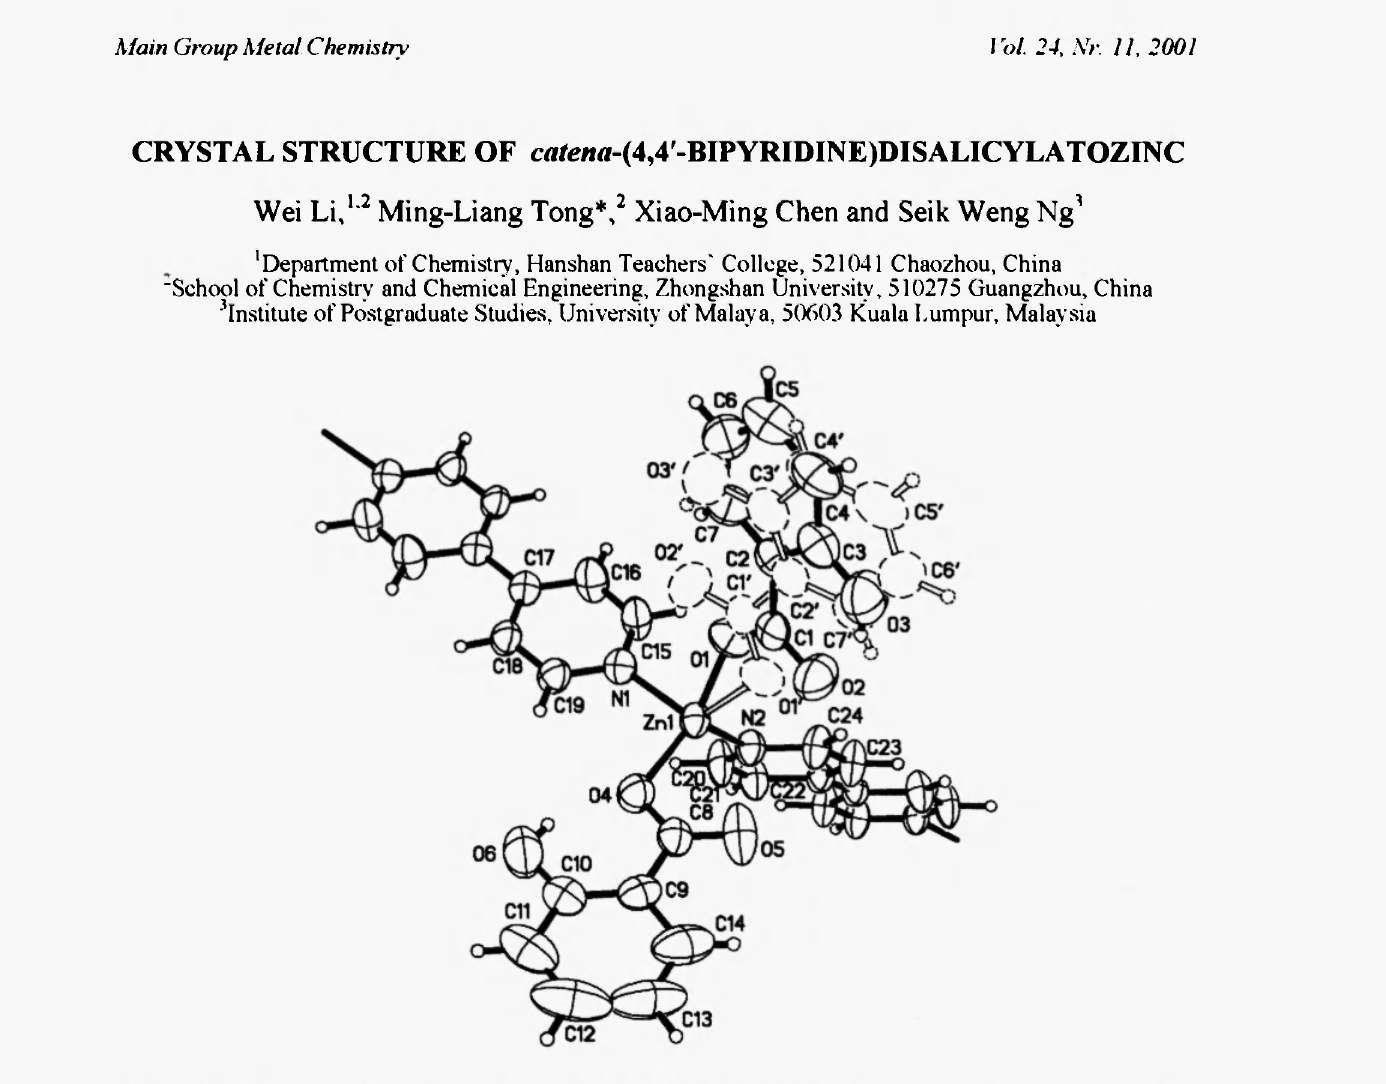
Figure 1. ORTEP plot (50% probability level) depicting the geometry of the zinc atom in polymeric (4.4 - bipyridine)disalicylatozinc. One of the salicylate group is disordered, and ellipsoids of one of the two components are dotted. The center-of-symmetry is midway along the C lw -„-C [llir „ bond of the 4,4- bipvridine. Selected bond distances and angles. Zni-Ol 1.948(5), Znl-ΟΓ 1.966(5), Znl-Q4 1.986(3). Znl- N1 2.077(3), Zn 1-N2 2.041(3) k\ 01-Znl-04 128.4(2). Ol-Znl-Nl 91.2(2). Ül-Znl-N2 112.9(2). ΟΓ- Znl-04 113.9(2), Ol'-Znl-Nl 122.5(2), ΟΓ-Ζη1-Ν2 1069(2), 04-Znl-Nl 97 5(1), 04-Znl-N2 115.2(1). Nl-Znl-N2